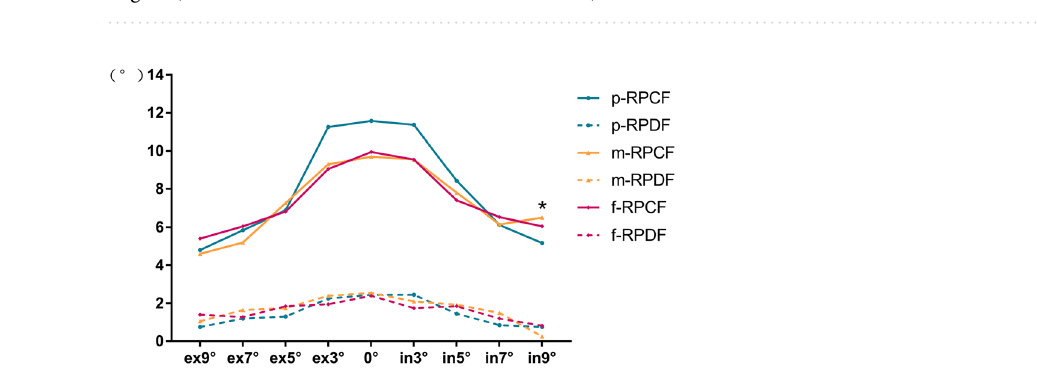
Figure 4. Break points of vergence fusion of the peripherial, macular and foveal fields at the different torsional angles. (ANOVA test, *P < 0.05, **P < 0.01, ***P < 0.001).